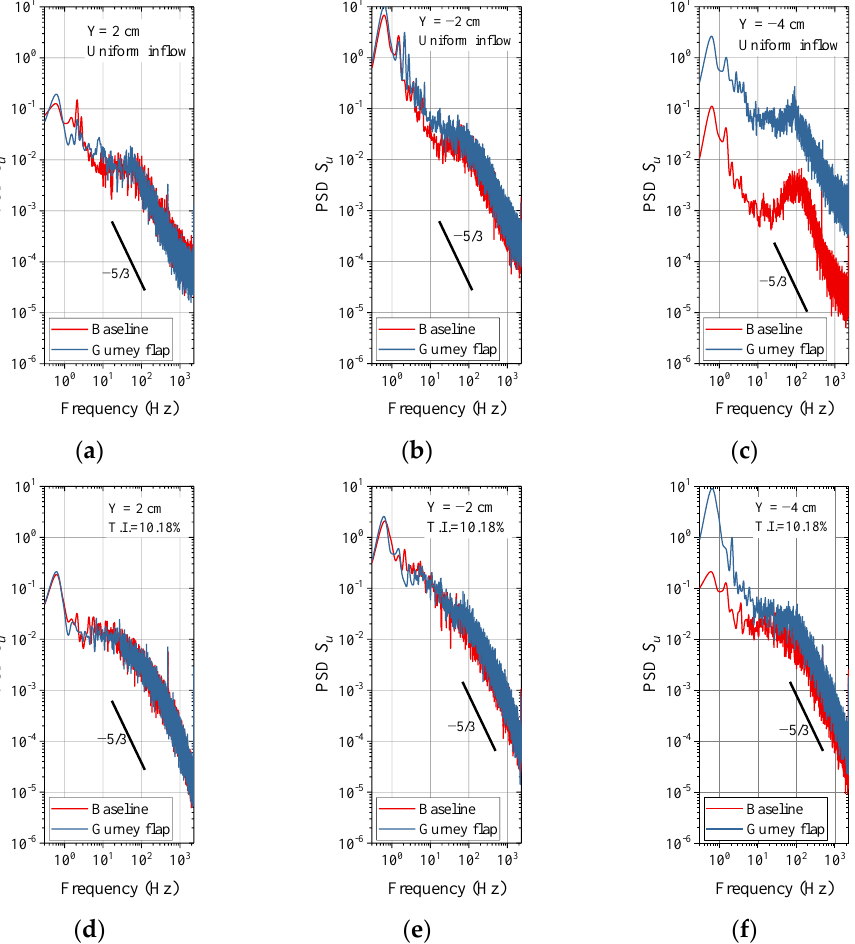
Figure 13. Comparison of the along wind PSD of the wake hysteresis loops. ( a ) uniform inflow, Y = 2 cm; ( b ) uniform inflow, Y = − 2 cm; ( c ) uniform inflow, Y = − 4 cm; ( d ) T.I. = 10.18%, Y = 2 cm; ( e ) T.I. = 10.18%, Y = − 2 cm; ( f ) T.I. = 10.18%, Y = − 4